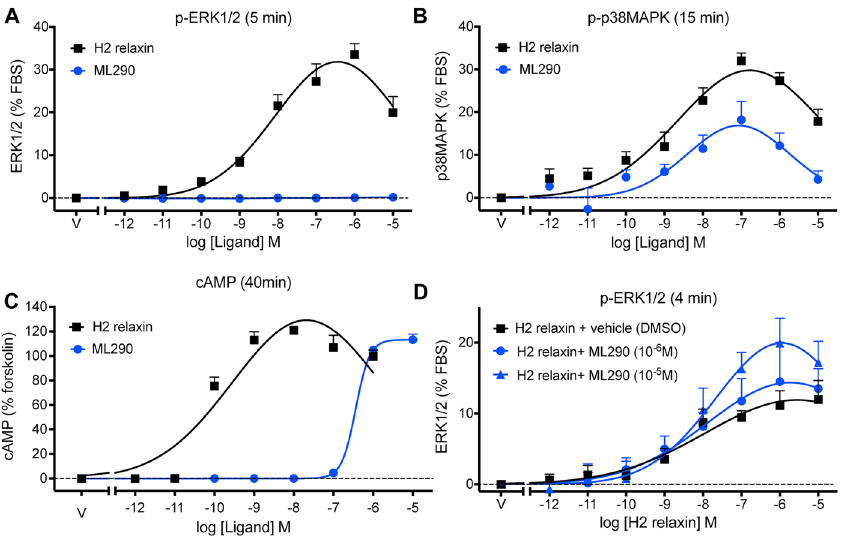
Figure 3. Activation of ERK1/2, p38MAPK and generation of cAMP by H2 relaxin and ML290. In HEK- RXFP1 cells, H2 relaxin activated p-ERK1/2 ( A ) 5 min), p-p38MAPK ( B ) 15 min) and cAMP accumulation ( C ) 30 min) in a concentration-dependent manner. ML290 did not directly activate p-ERK1/2 ( A ), but did activate p38MAPK ( B ) with lower efficacy and cAMP accumulation with similar efficacy but significantly lower potency than H2 relaxin ( C ). 10 min pretreatment with ML290 enhanced p-ERK1/2 activation produced by relaxin ( D ) 4 min). Data are mean ± SEM for 4–8 independent